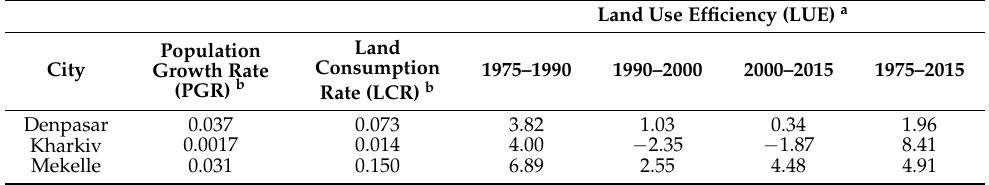
Table 4. Land Use Efficiency (LUE) for Denpasar, Indonesia; Kharkiv, Ukraine; and Mekelle,